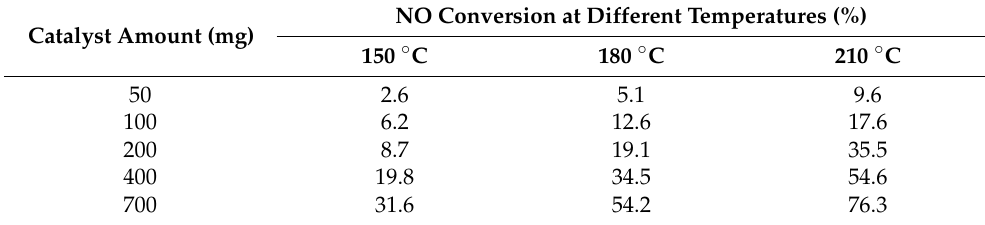
Table 1. SCR activity in an integral